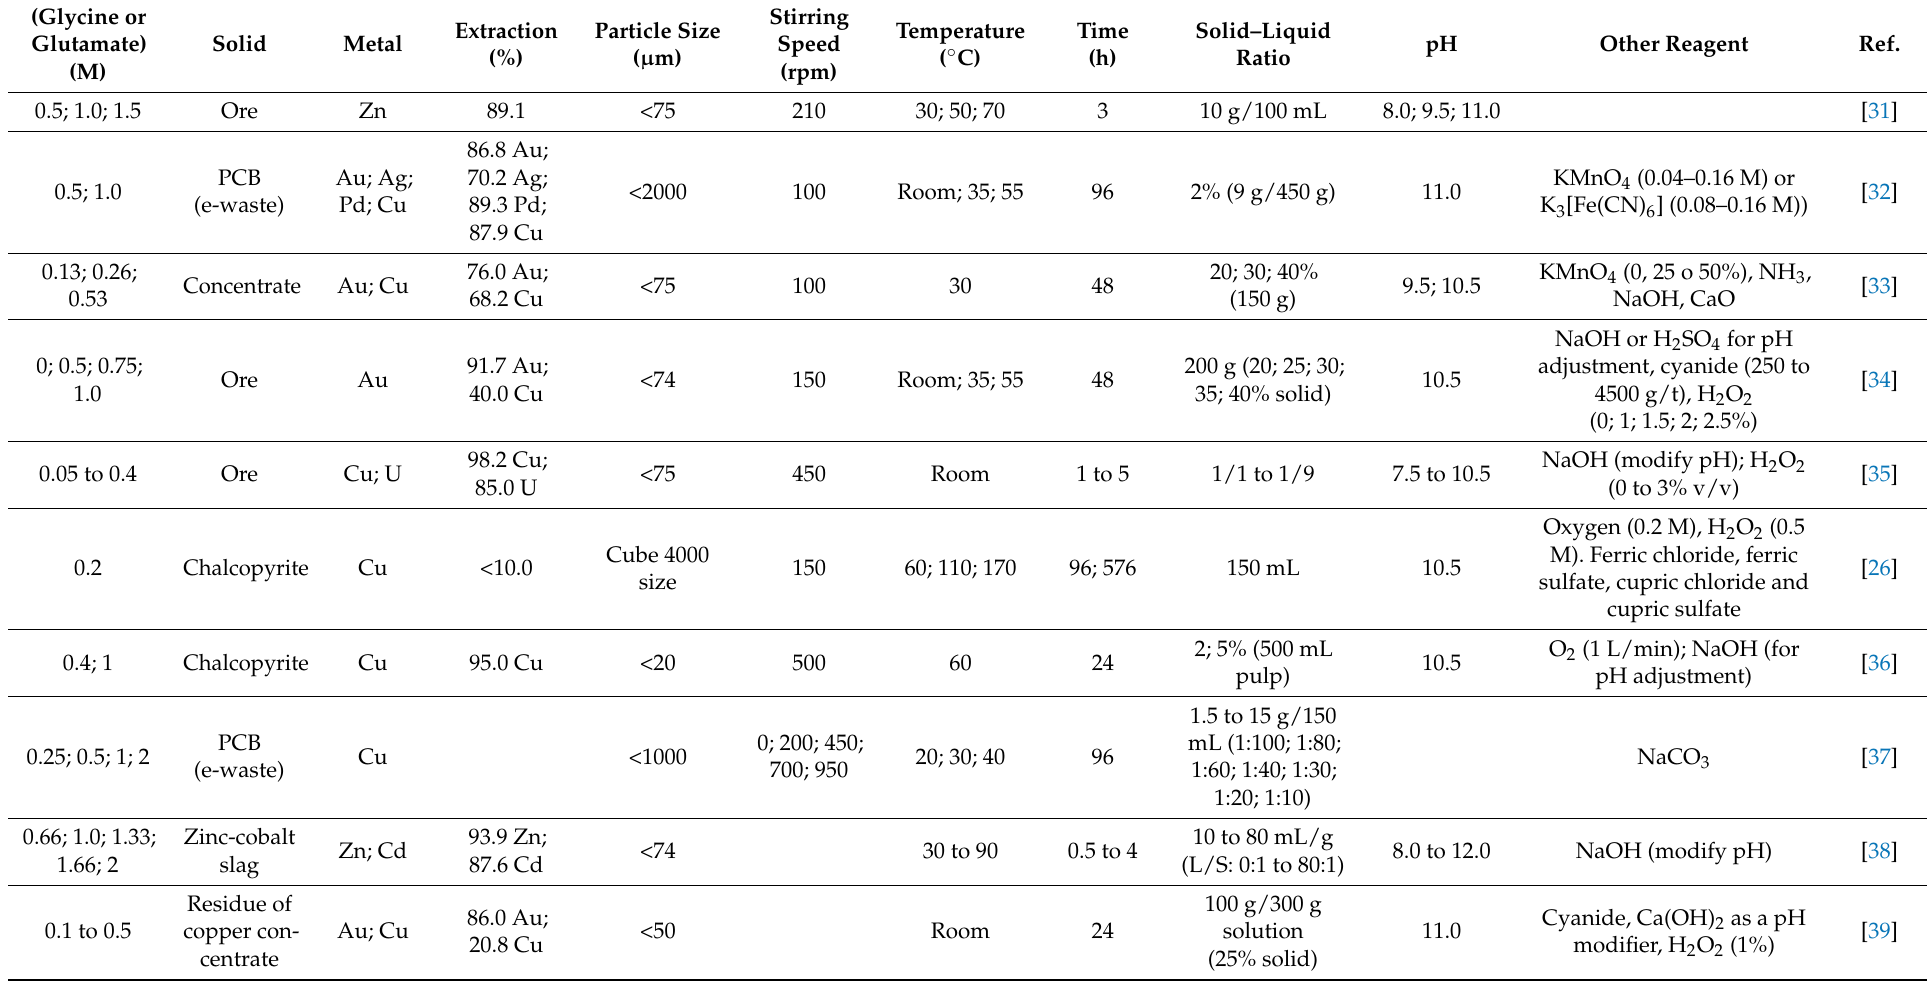
Table 6. Operational leaching conditions of laboratory test using glycine (data from 2018 to